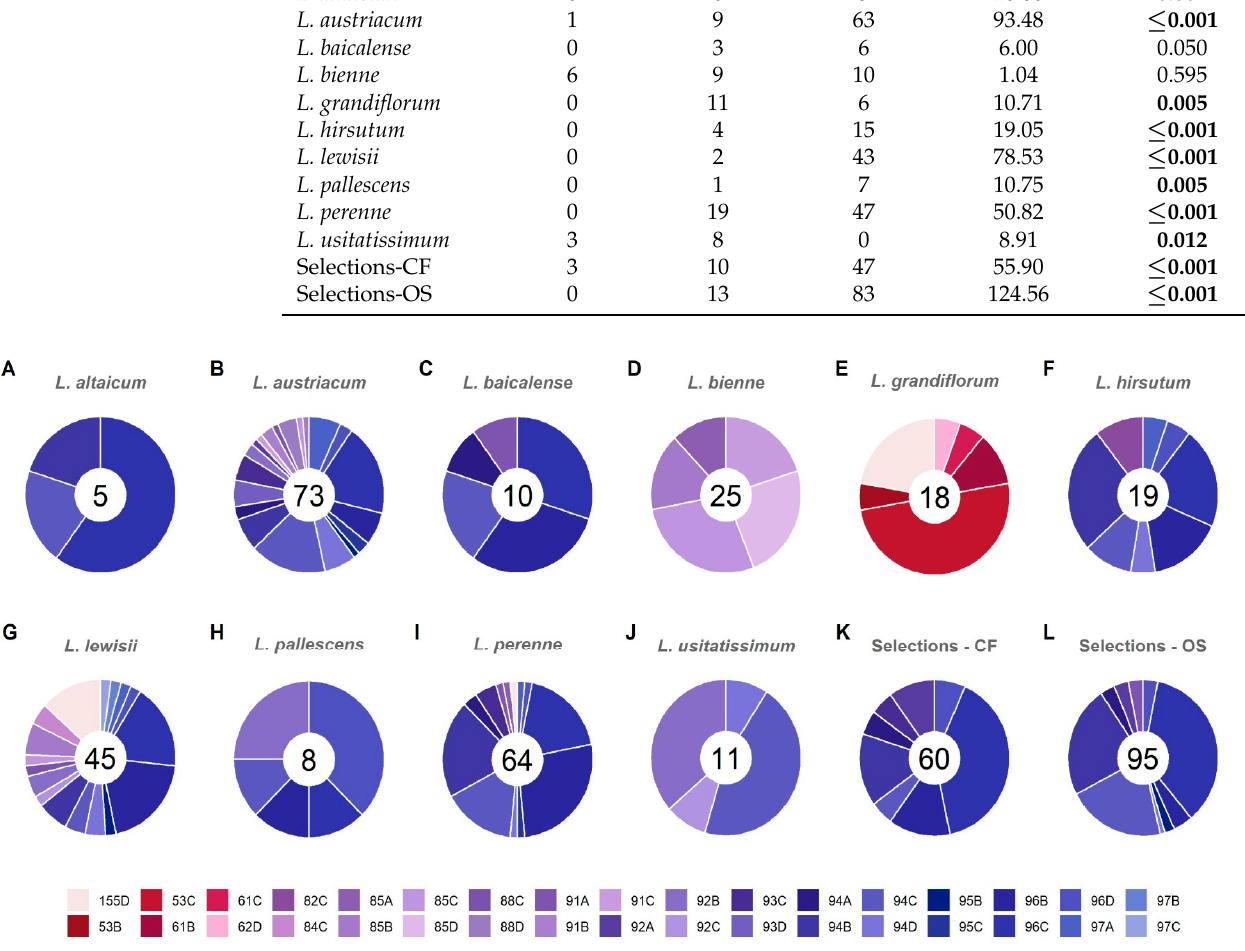
Figure 4. Flower color (Royal Horticultural Society, RHS codes) proportion by Linum species and populations: ( A ) L. altaicum , ( B ) L. austriacum , ( C ) L. baicalense , ( D ) L. bienne , ( E ) L. grandiflorum , ( F ) L. hirsutum , ( G ) L. lewisii , ( H ) L. pallescens , ( I ) L. perenne , ( J ) L. usitatissimum , ( K ) Selections–CF, ( L ) Selections-OS. Number of observations are displayed in the center of each donut chart. RHS color codes were converted to hexRGB values